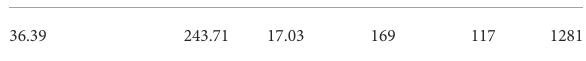
TABLE 1 Average summary characteristics of sequenced SARS-CoV- 2 samples by ONT